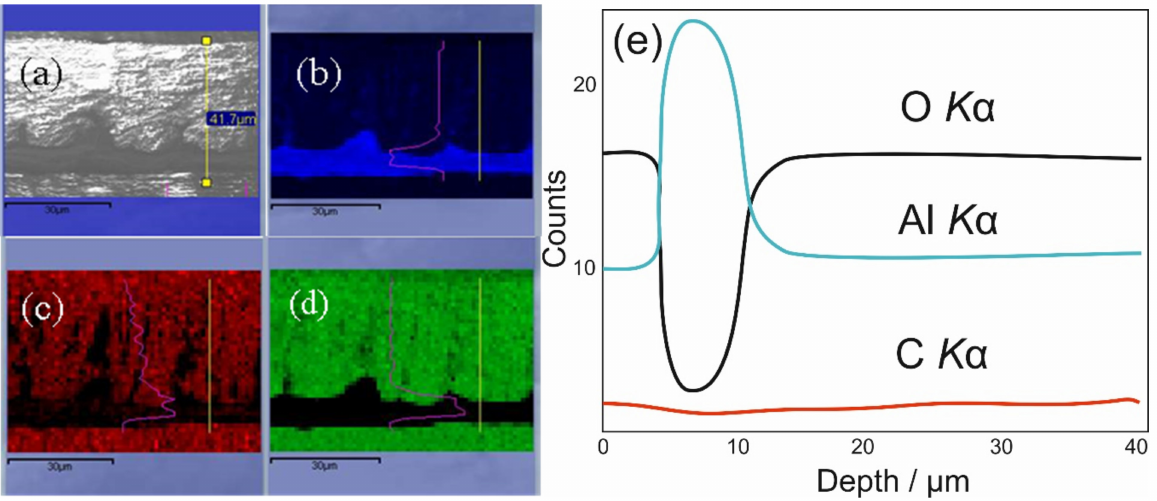
Figure 7. Cross-sectional image of AAO/carbon composite film ( a ) and EDS mapping of aluminum ( b ), carbon ( c ), and oxygen ( d ) elements. ( e ) Cross-sectional distribution curves of oxygen, aluminum, and carbon elements in the film formed as in Figure 3 at 80